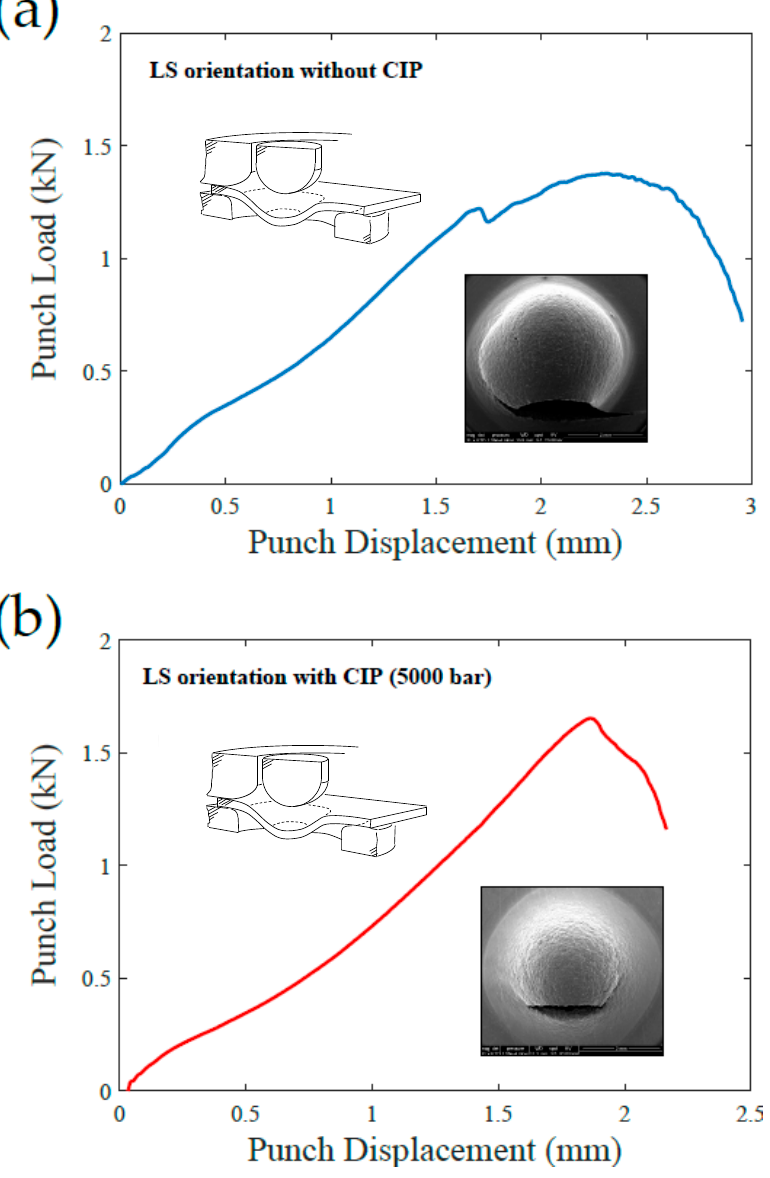
Figure 6. SPT load–displacement curves for specimens showing premature fracture in L direction: ( a ) B3 specimen and ( b ) E3 specimen.